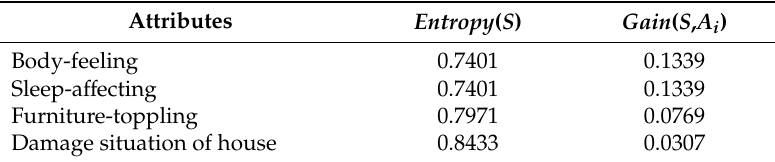
Figure 2. The pseudo code of the classification. Table 2. The value of entropy and information gain of every attributes.